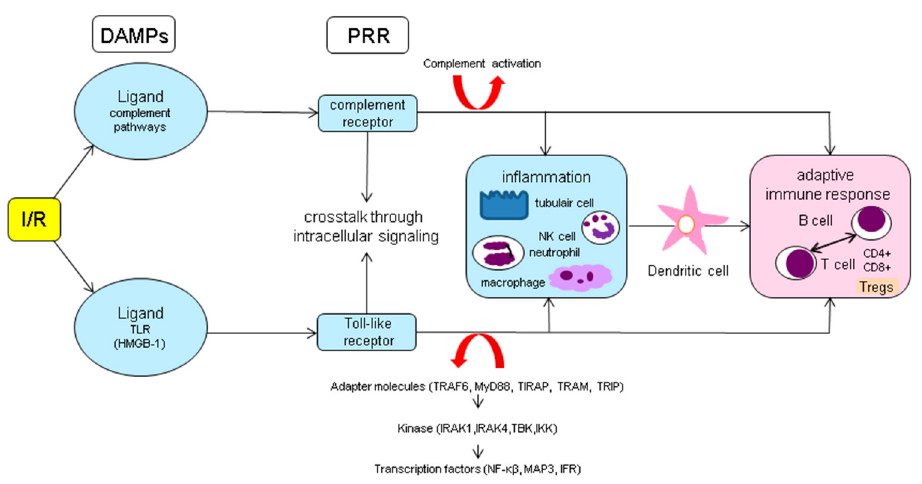
Figure 8. Interaction of the innate and adaptive immune system in the pathophysiology of ischemia and reperfusion injury. DAMPs released upon I / R are able to activate the innate immune system by binding to PRRs like complement receptors and TLRs. Activation of these receptors will lead to production of pro-inflammatory cytokines and chemokines and chemotaxis, opsonisation and activation of leucocytes like macrophages, neutrophils and natural killer (NK) cells. Additionally, immature dendritic cells can be activated, which, after maturation, are able to activate the adaptive immune system in a direct manner by antigen presentation to B- and T-cells or indirectly via cytokine signalling. Treg: regulatory T-cell.